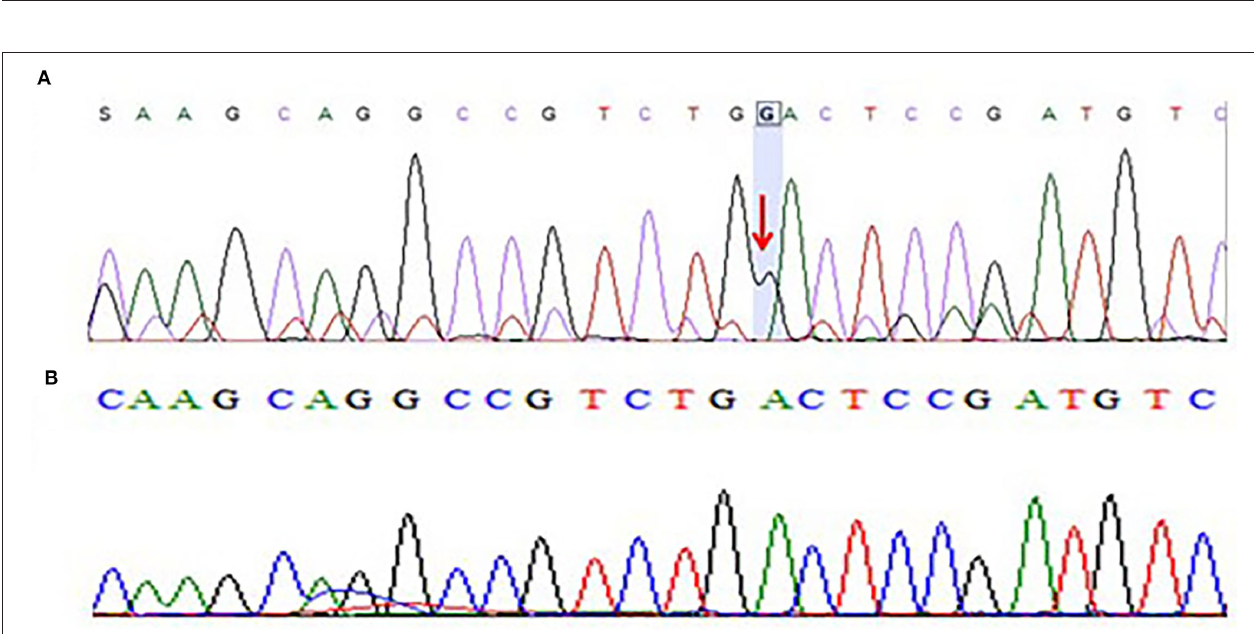
FIGURE 4 | (A) Chromatogram of Sanger sequencing showing one base pair insertion of “G” nucleotide in exon 3 of CACNB4 gene sequence of c.78_79insG, p.Asp27Glyfs*26 in three different patients from the cohort of 25 epileptic sporadic patients leading to a frameshift mutation. (B) Chromatogram of Sanger sequencing showing wild-type sequence of the CACNB4 gene (obtained from 100 healthy individuals as the control group).